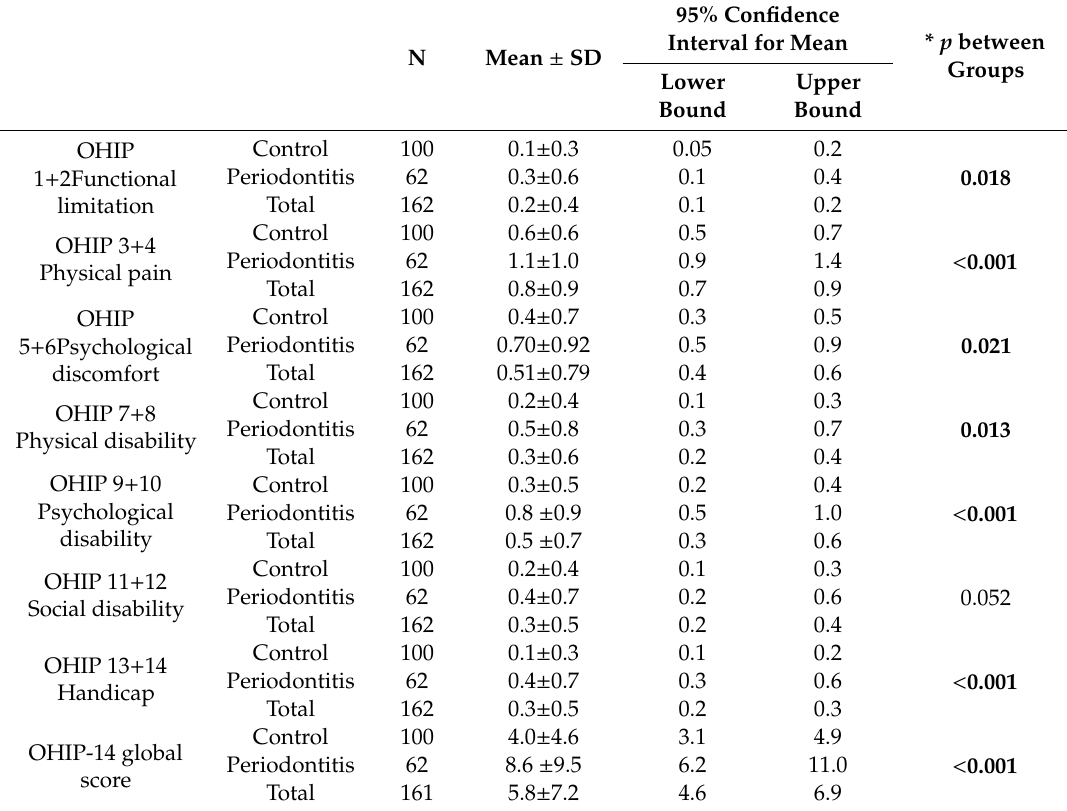
Table 4. The Mean Oral Health Impact Profile Scores (OHIP-14) global and domain scores of the study population.